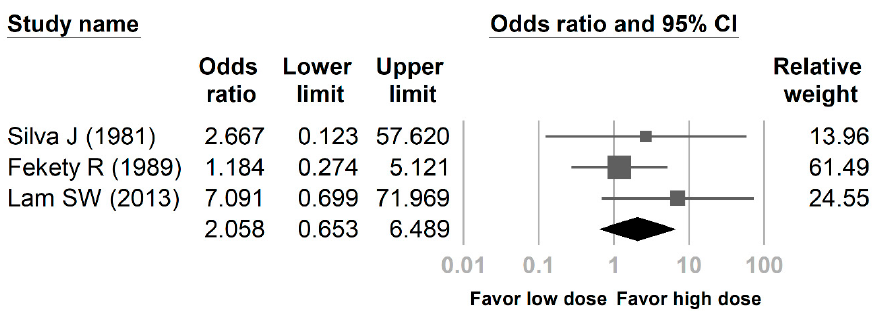
Figure 2. Forest plot presenting the odds ratio (OR) of recurrence in patients with initial episodes of Clostridioides difficile infection treated with low dose vancomycin versus high dose vancomycin.